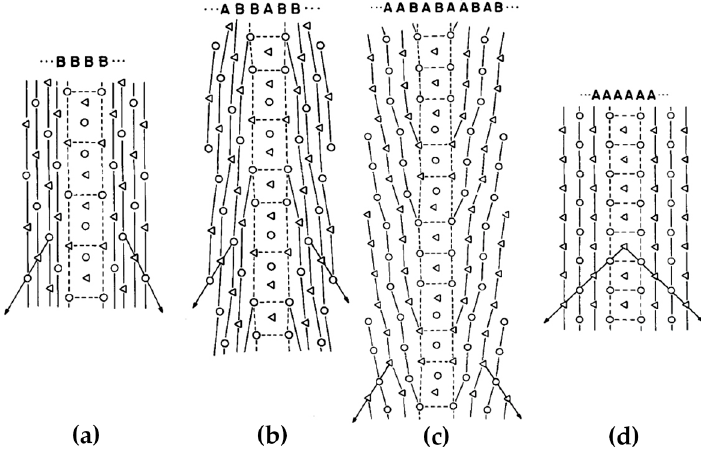
Figure 5. Illustrations of perfect Σ = 5, 17, 37 and 1 grain boundaries from ( a – d ), respectively. (Reprinted from Reference [26], with permission from Elsevier) (Reprinted from Reference [26], with permission from